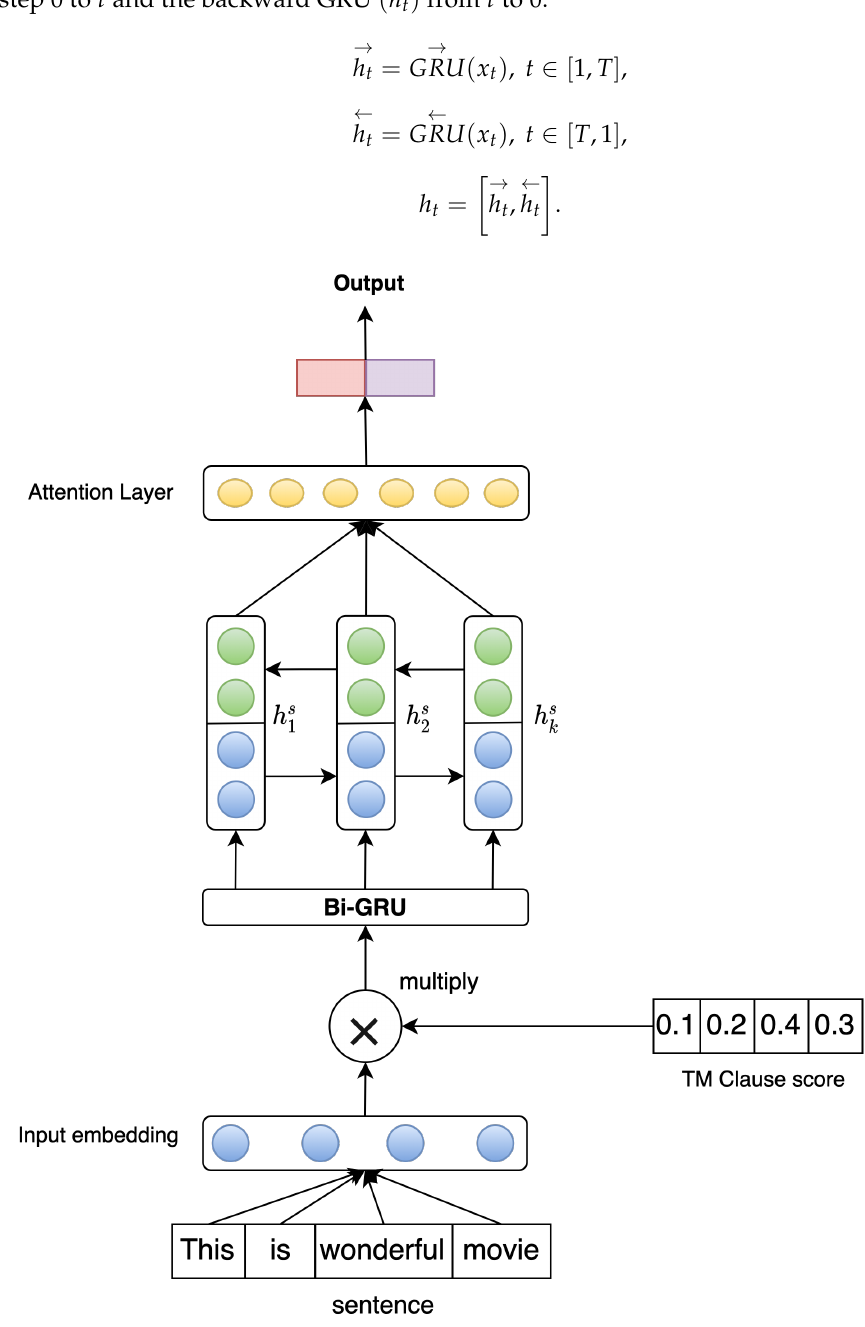
Figure 2. The two-action TA and its transition in